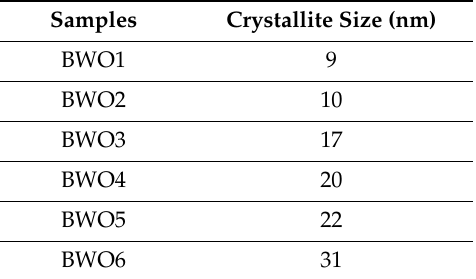
Table 2. Rietveld structural parameters of the samples.